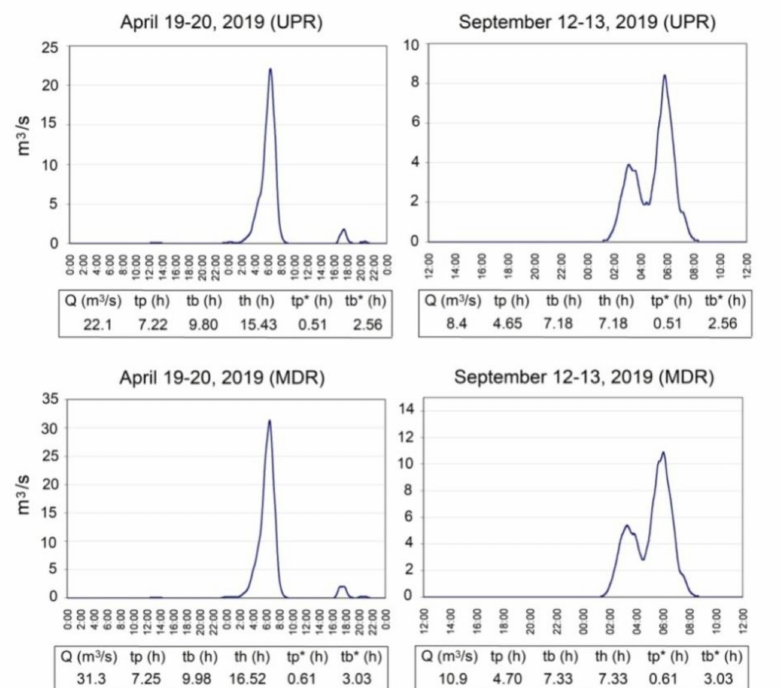
Figure 4. Hydrographs and associated parameters for the flood events of 19–20 April 2019 and 12–13 September 2019, estimated in intermediate cross-sections of the UPR and MDR stretches. Q = discharge (m 3 s − 1 ); tp = time of peak (h); tb = base time (h); th = hydrograph duration (h); tp* and tb* = time of peak and base time of the unit hydrograph